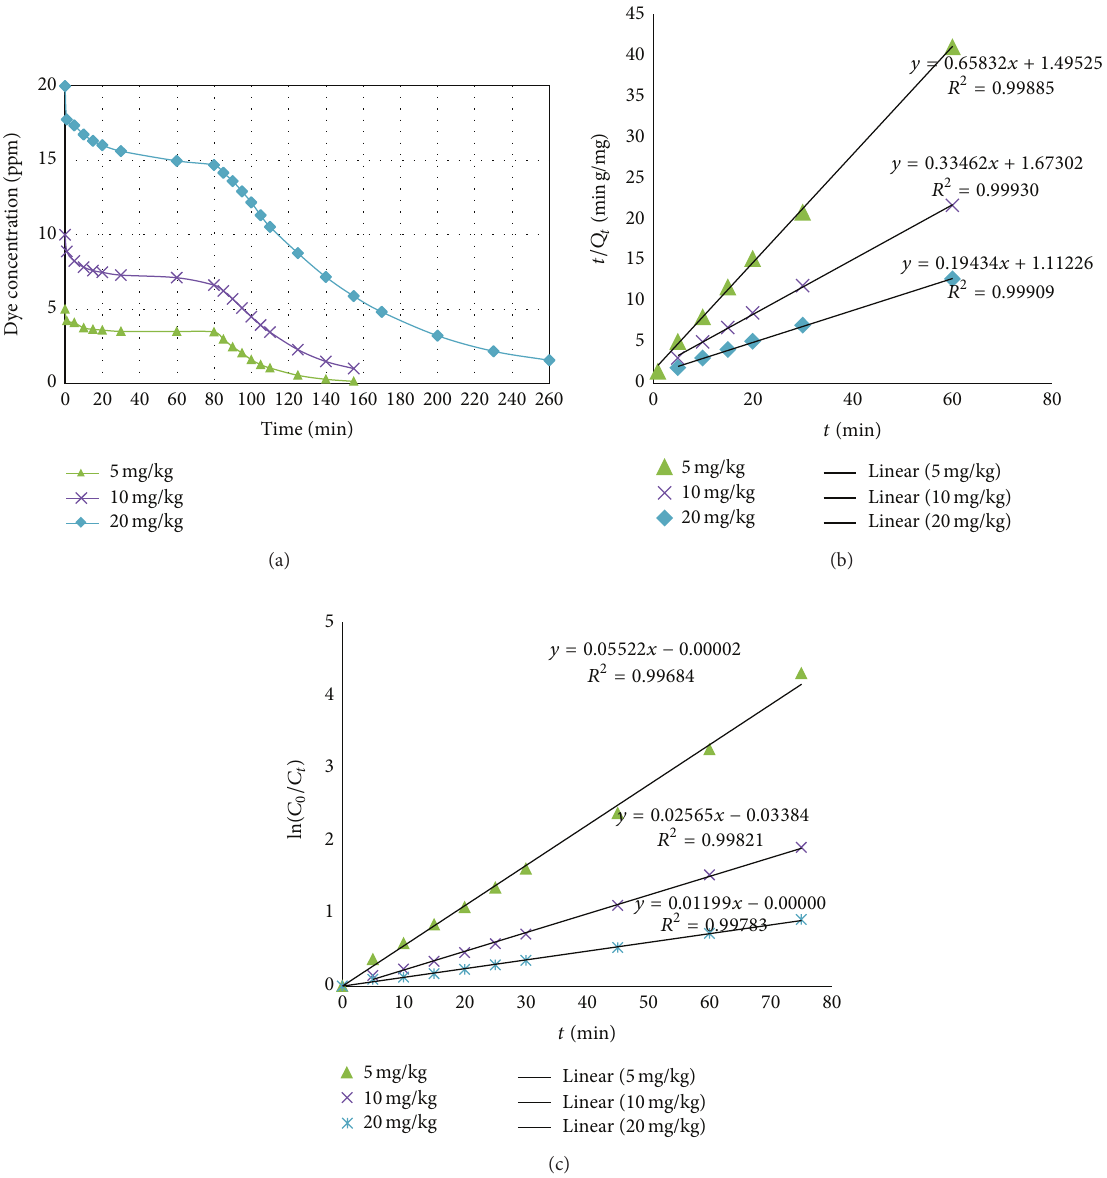
Figure 12: (a) Methyl orange adsorption-photodegradation curves at various initial concentrations; (b) the corresponding linearized plots of pseudo-second order adsorption kinetics; and (c) the corresponding linearized plots of pseudo-first order photodegradation